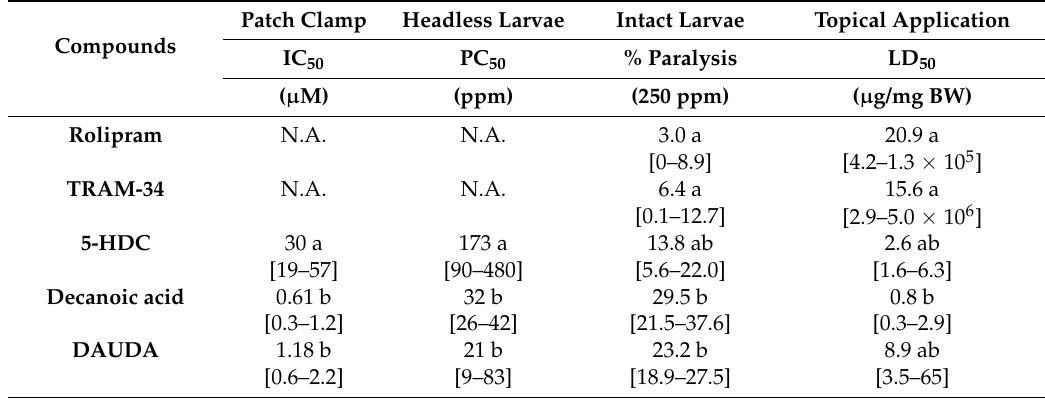
Table 1. Activity of each compound across different assays. Calculated values and 95% CI [in brackets] are given for Ag Kv2 channel inhibition (Patch-Clamp: IC 50 ), paralysis (Headless Larvae: PC 50 , and Intact Larvae: percentage) and lethality (Topical Application: LD 50 to adult females). Statistical significance was assessed according to non-overlap of 95% CI, where means within a column not labeled by the same letter are different ( p < 0.05).